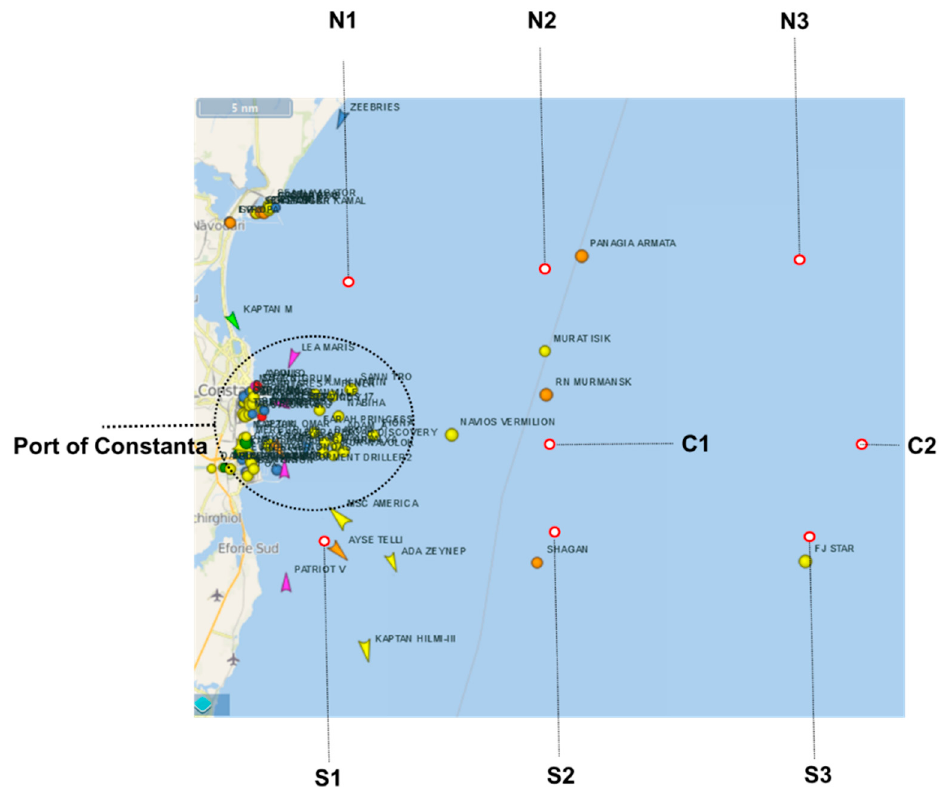
Figure 2. Location of the reference points and the port of Constanta activities reported for the time frame 17/07/2020 16:30 h. Results processed from Black Sea ship traffic [20].